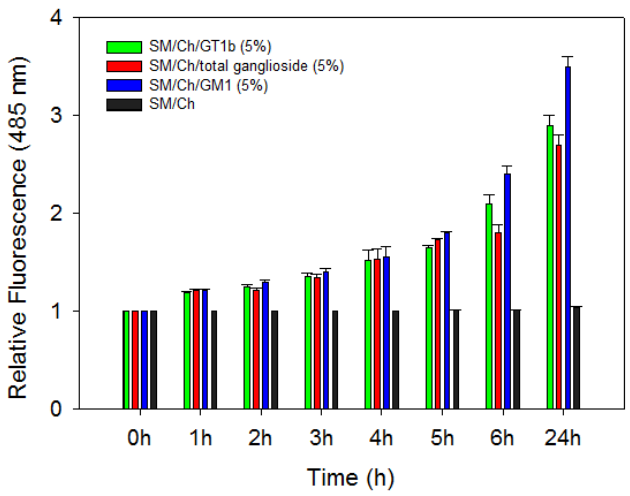
Figure 1. Time course of thioflavin T relative fluorescence emission after addition of A β 42 to a LUV suspension containing SM / Chol (1:1 mol ratio) ± 5 mol% gangliosides. The data have been normalized to time 0. Average values ± S.E. ( n =